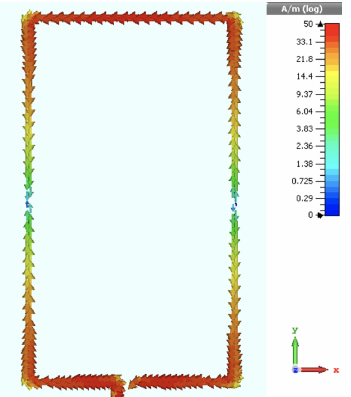
Figure 3. Snapshot of computed surface current distribution for the wearable loop